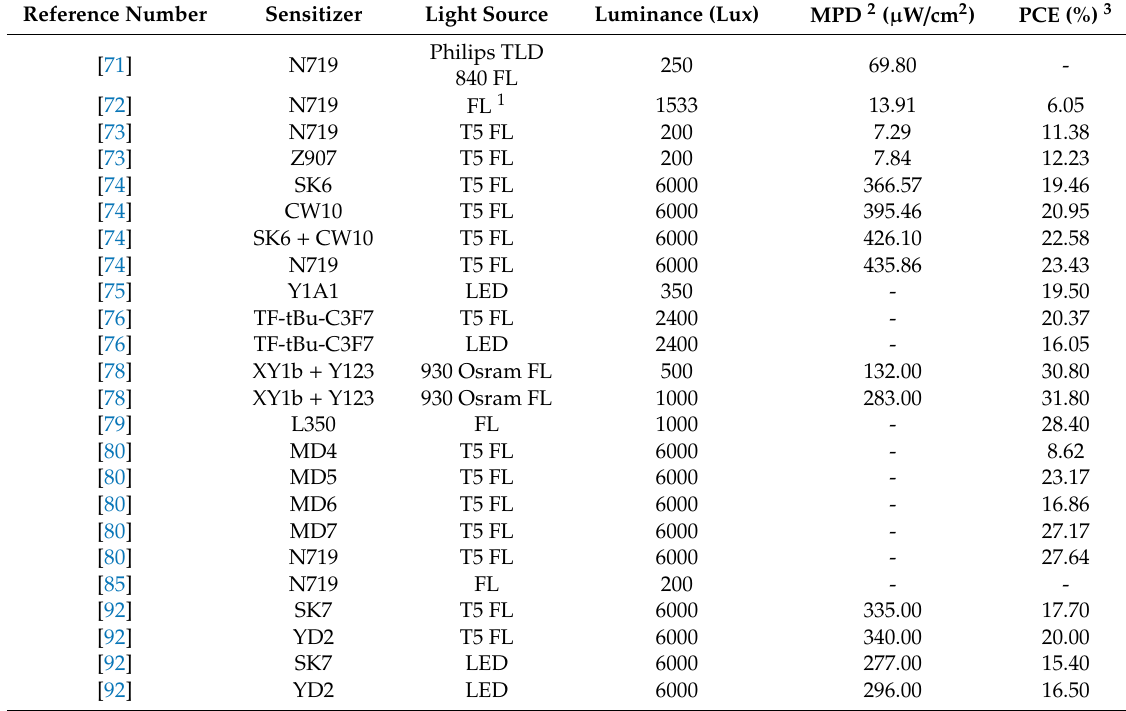
Table 2. Summary of previously reported studies on DSSCs for indoor applications.